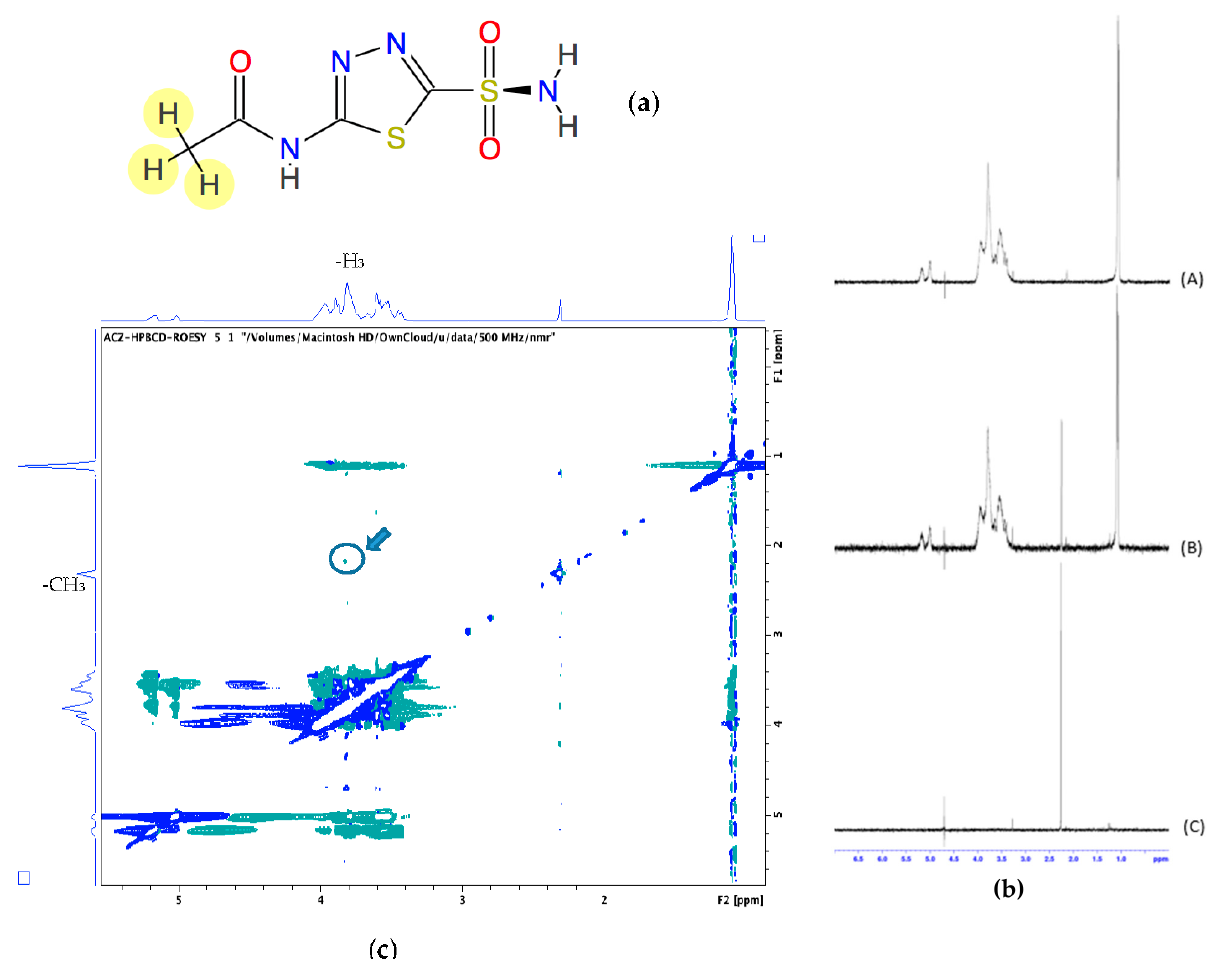
Figure 2. ( a ) Chemical structure of acetazolamide (Acz); ( b ) 1H-NMR corresponding to HP β CD ( A ), Acz/HP β CD (1:1) ( B ), and Acz ( C ). ( c ) 2D-ROESY spectrum of Acz/HP β CD (1:1). The highlighted circle indicates the crosspeak between H3 and the protons of the acetamide group of